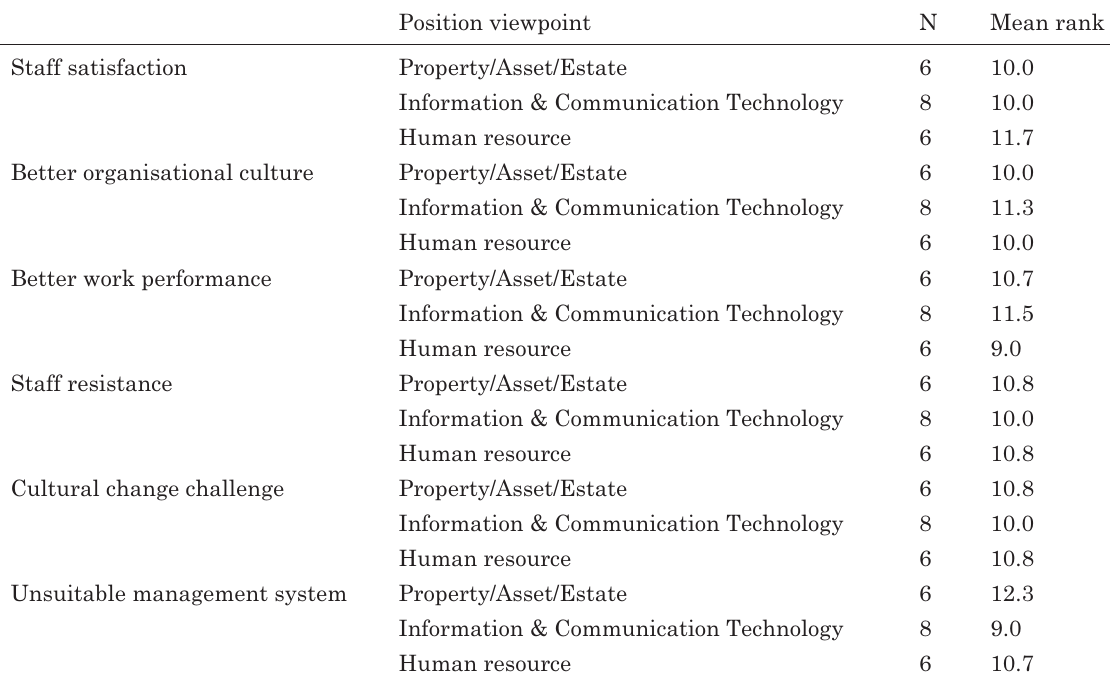
Table 7. Mean rank for Kruskal Wallis Test of Non-territorial working